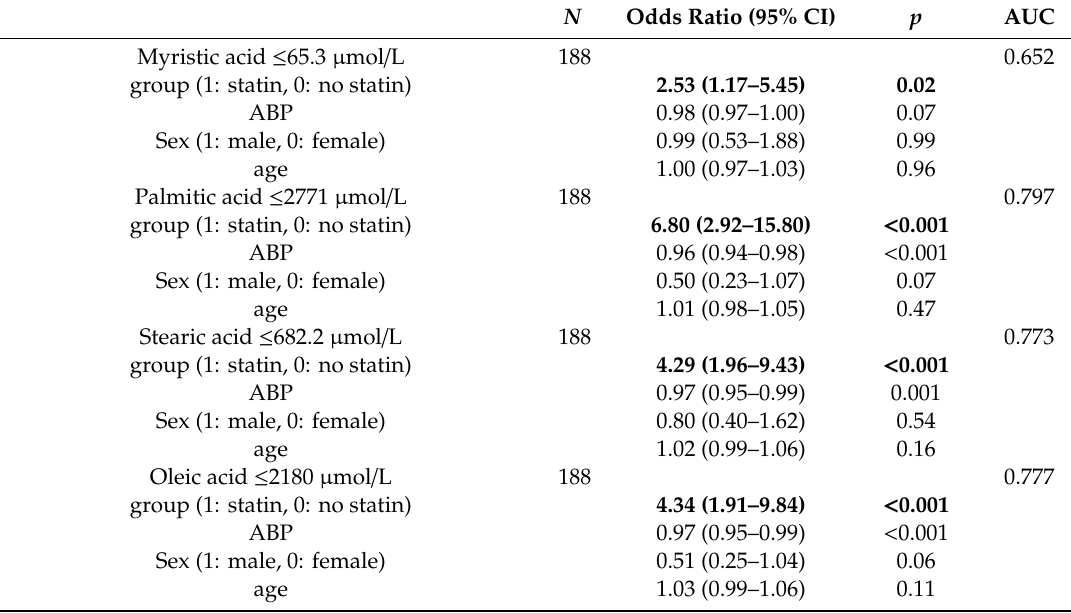
Table 4. Multiple logistic regression analysis for low levels of SFAs and n-9 MUFA adjusted to age, sex. ABP, and group.